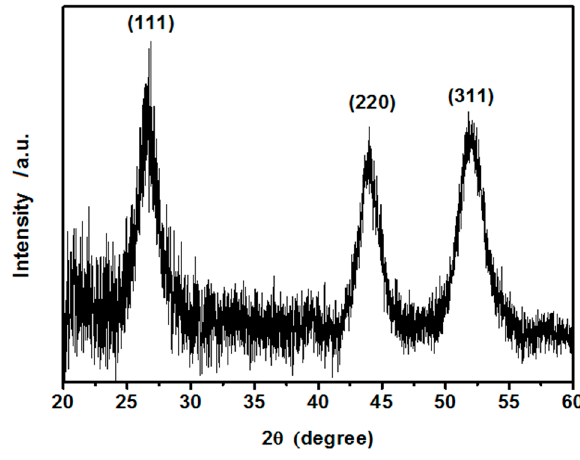
Figure 2. Powder X-ray diffraction pattern of as synthesized CdS crystalline hydrophilic nanoparticles with assigned hkl